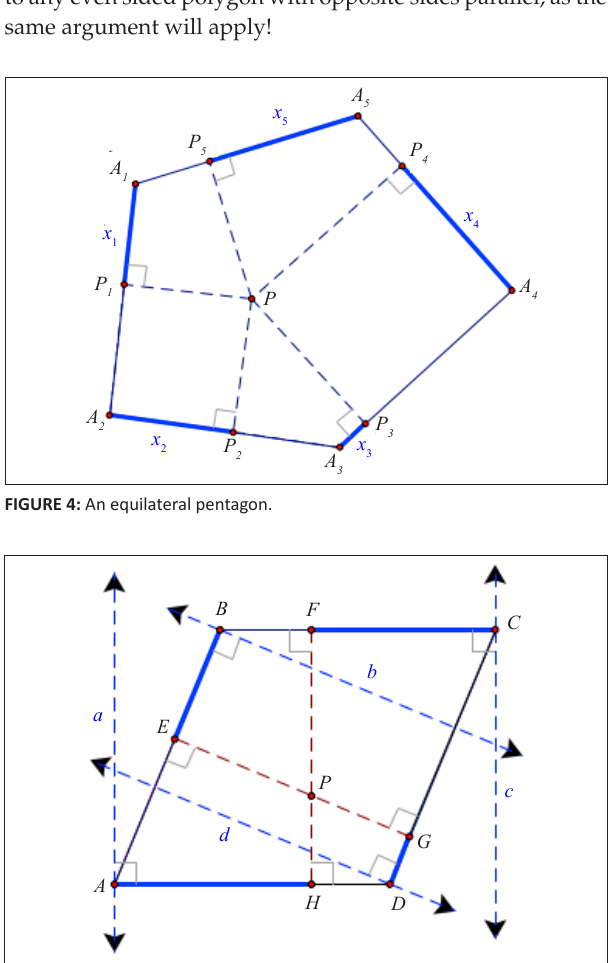
FIGURE 5: A geometric proof for a